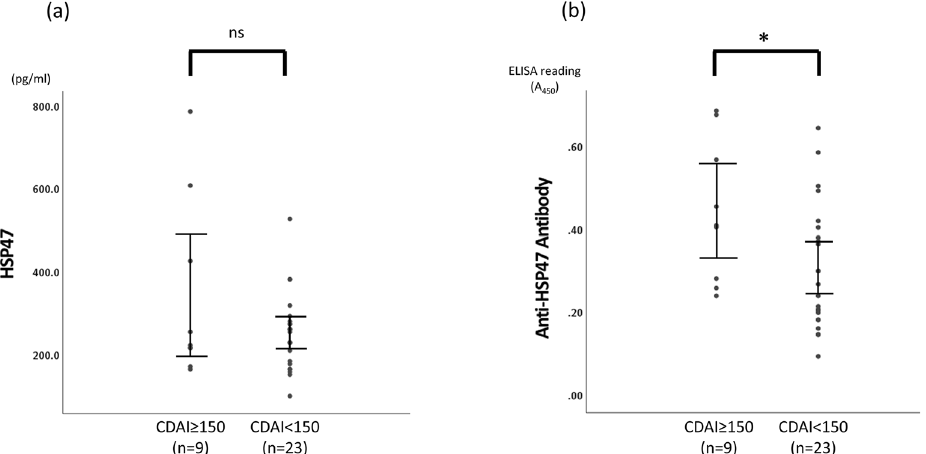
Figure 2. Comparison of serum HSP47 and anti-HSP47 antibody levels between CDAI < 150 and CDAI ≥ 150 groups. ( a ) Quantitative analysis of HSP47 levels in the CDAI ≥ 150 (n = 9) and CDAI (n = 23) groups. ( b ) Quantitative analysis of anti-HSP47 antibody levels in the CDAI < 150 and CDAI ≥ 150 groups. Each dot represents one subject, and bars indicate average ± SEM. **P < 0.001 (Student’s t test). HSP heat shock protein, CDAI Crohn’s disease activity index, ns not significant.